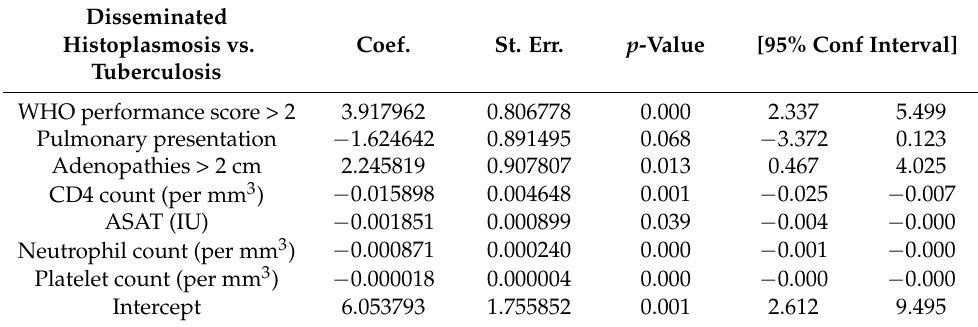
Table 1. Logit regression of the most parsimonious model according to Akaike’s information criterion.